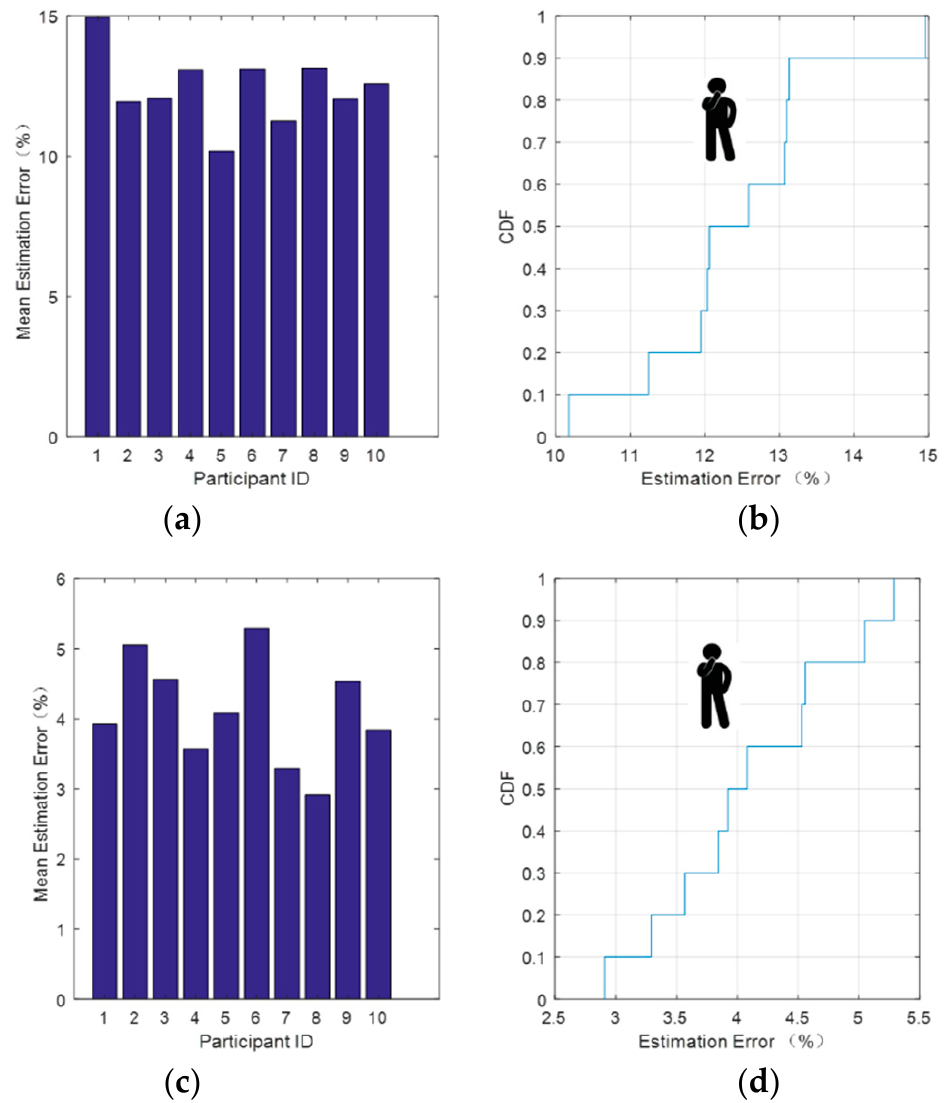
Figure 10. Respiratory signal relative error after data processing for the standing position. ( a ) Average error estimate and ( b ) CDF of the estimated error after soft threshold denoising. ( c ) Average error estimate and ( d ) CDF of the estimated error after hard threshold denoising.